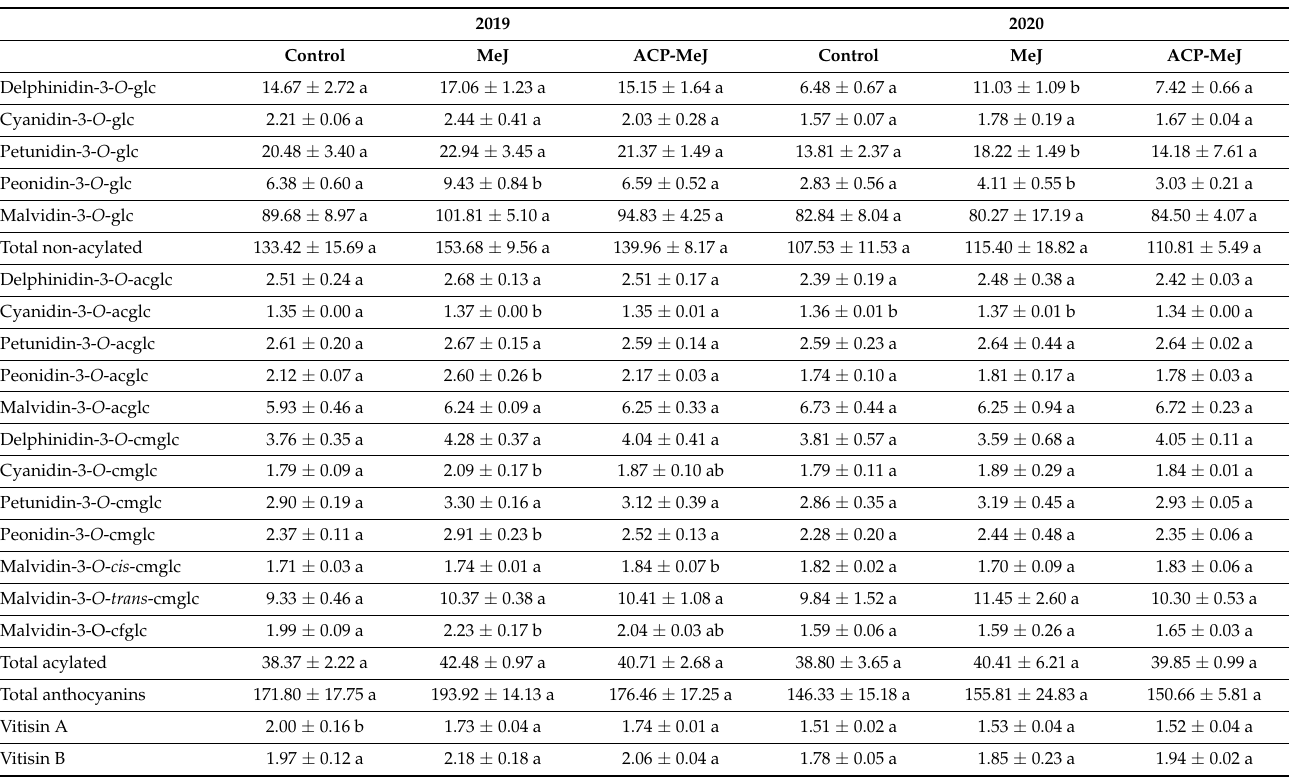
Table 2. Anthocyanins content (mg/L) in wines from control, methyl jasmonate (MeJ) and